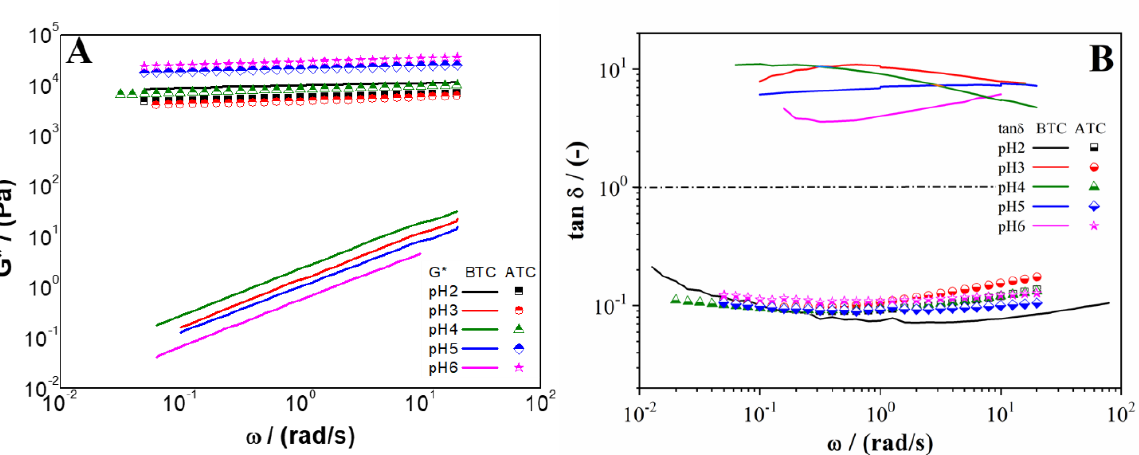
Figure 3. Dependence of complex moduli (G*) ( A ) and loss tangent (tan δ) ( B ) on frequency value for the egg yolk acidulated with citric acid before thermal cycle (BTC) and after thermal cycle (ATC) as a function of pH (2, 3, 4, 5, and 6).